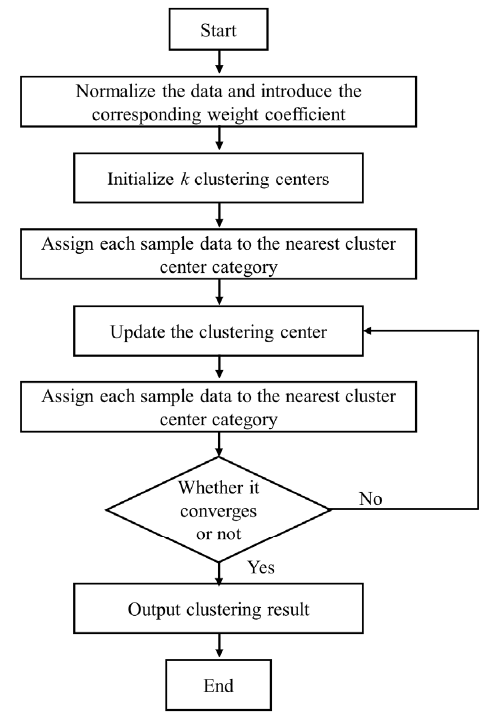
Figure 5. Flowchart of the improved K ‐ means algorithm.